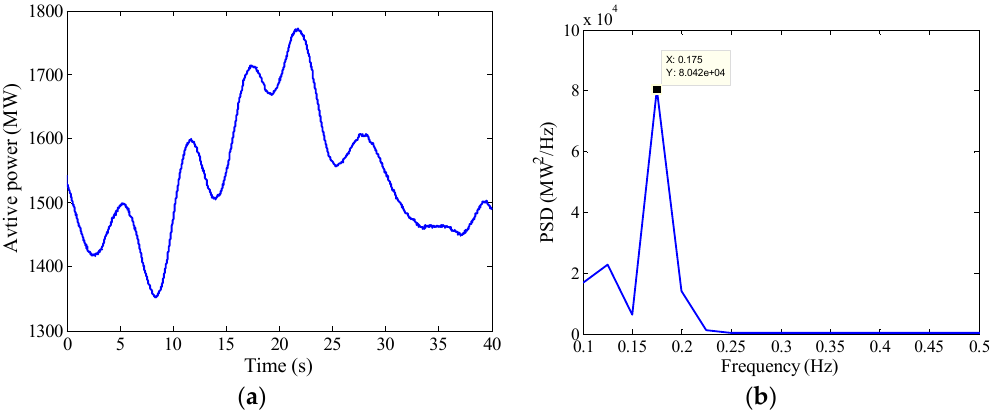
Figure 7. Properties of the simulated UHV tie line oscillation in both time and frequency domains. ( a ) Simulated oscillation curve; ( b ) Corresponding PSD.